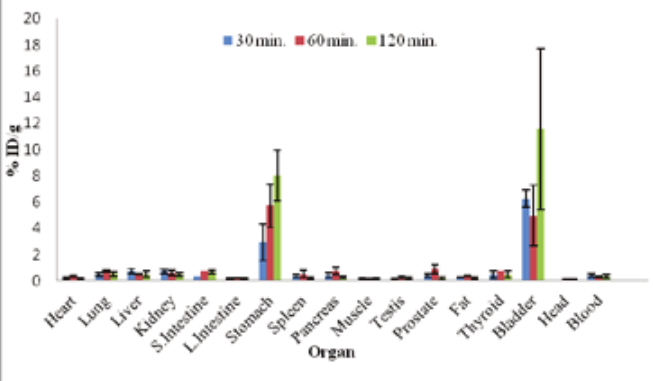
FIGURE 4 - %ID/g of 131 I-Peak 7 for male Wistar albino rats.